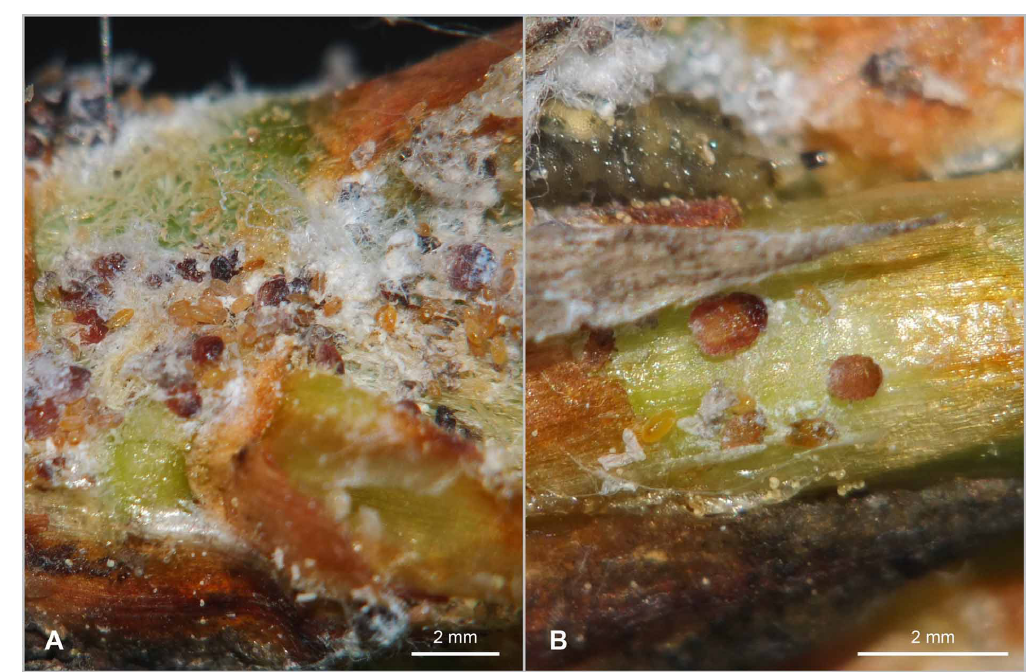
Fig. 78. Pineus (Pineus) cembrae (Cholodkovsky, 1888). Apterae with eggs and juveniles on young growth of Pinus cembra . (wax wool removed). In B, also a syrphid (Diptera, Syrphidae) larva.